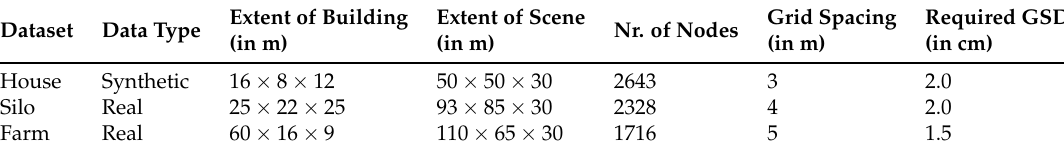
Table 1. Statistics of the datasets used in our